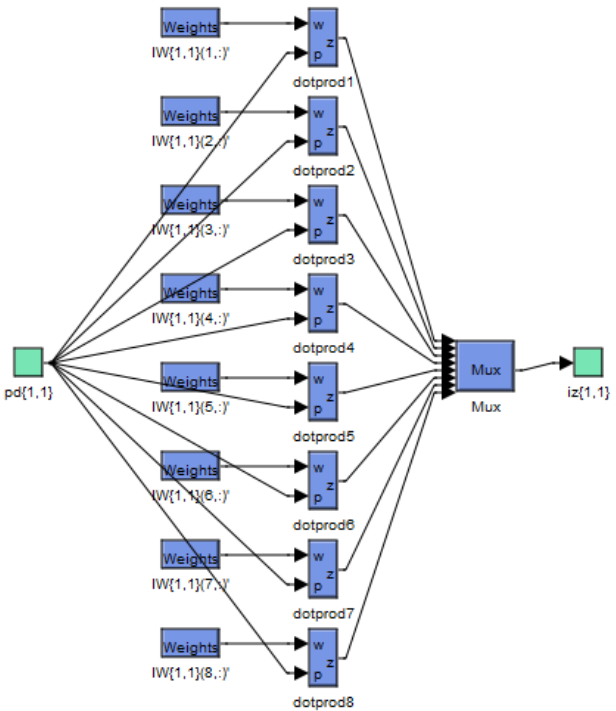
Figure 15. Schematic diagram of the hidden Layer.